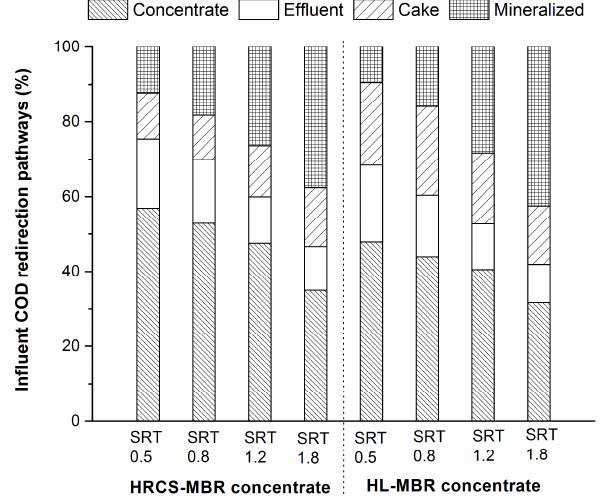
Figure 5. Total COD mass balances over the entire steady-state period of the experiment at different SRTs for both MBRs.